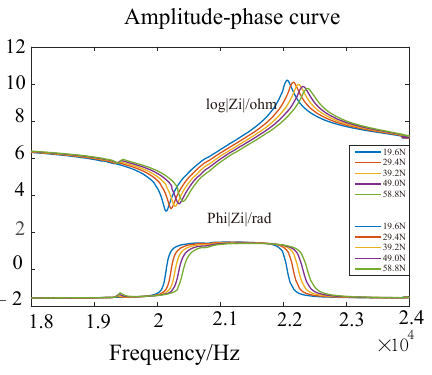
Figure 6. Amplitude-phase curve of the piezoelectric transducer under different load. Based on the equivalent circuit model, the electrical parameters of the piezoelectric transducer corresponding to the radiated acoustic impedance of the front cover with different impedance characteristics are calculated separately. It is assumed that the range of radiated acoustic impedance of the front cover change during loading is resistive (0 to 1000), inductive (1 + 1 i , 1 + 11 i , 1 + 21 i , ..., 991 + 991 i ), and capacitive (1 − 1 i , 1 − 11 i , 1 − 21 i , ..., 991 − 991 i ), respectively. According to the component parameters information of the piezoelectric transducer in Table 2 and Equations (1)–(5). Matlab is used to calculate the amplitude-phase characteristics of the piezoelectric transducer under different Z ft . The amplitude-phase curves of the piezoelectric transducer are shown in Figures 7–9.